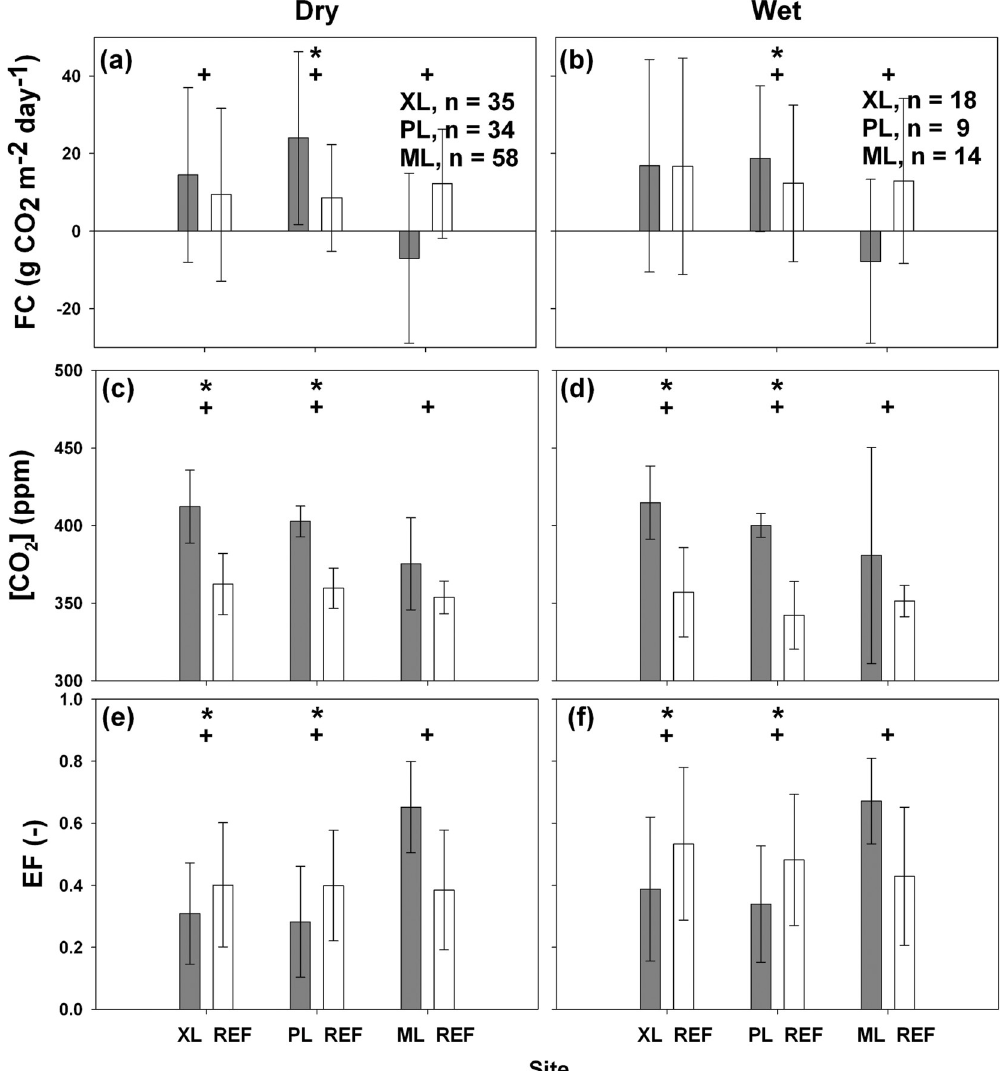
Fig 9. Daily averages of FC , [CO 2 ] and EF for dry and wet days. Comparisons of averaged daily (a, b) FC , (c, d) [CO 2 ], and (e, f) EF for dry (left) and wet (right) days during simultaneous periods. n is the number of days and error bars represent ± 1 daily standard deviations. Statistical significance ( p � 0.05) is tested between dry and wet days in the same site (shown with � ) and between the mobile deployment and REF site (shown with +).